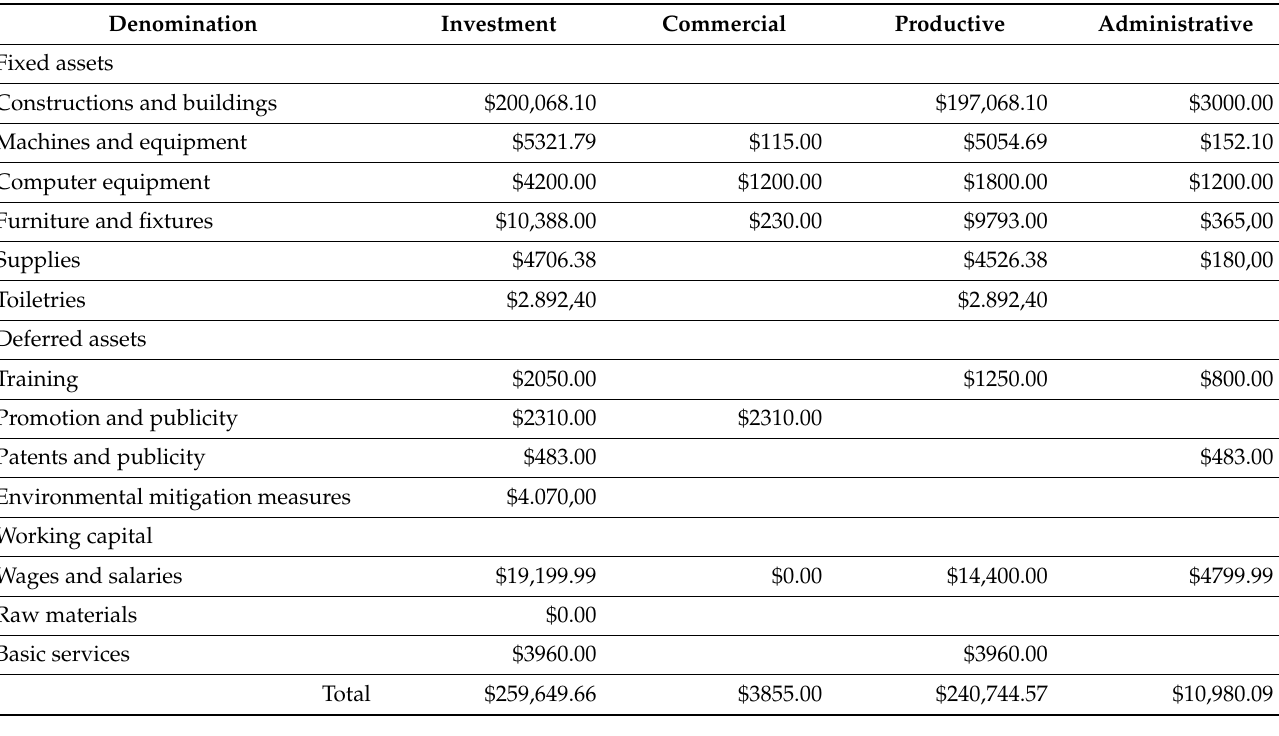
Table 4. Investments.